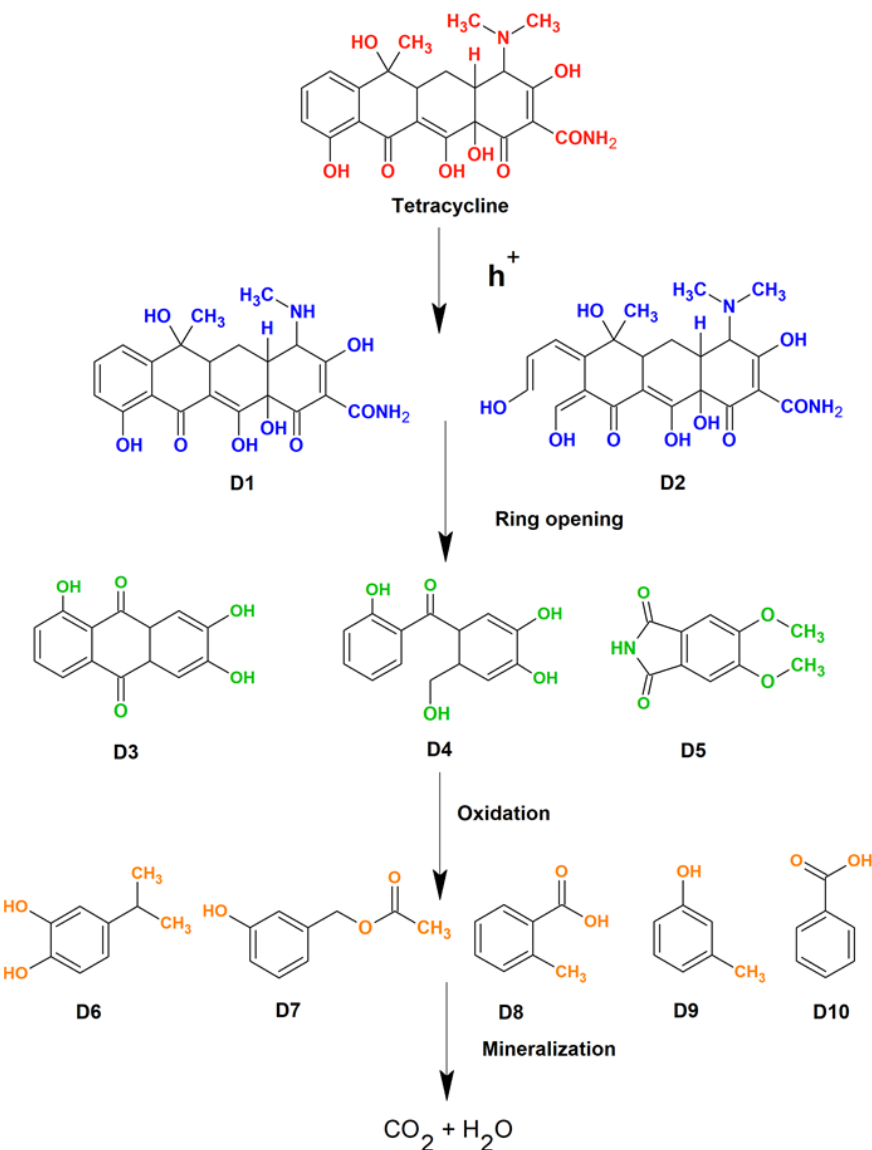
3. Figure 12. Schematics showing reaction intermediates in the detailed degradation pathway.